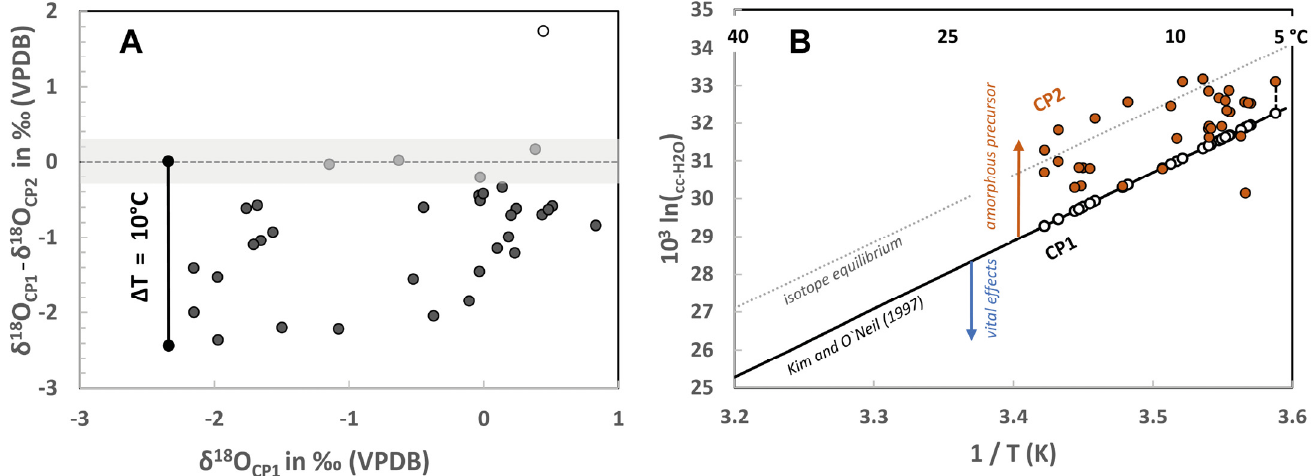
Figure 4. ( A ) Difference between the oxygen isotope composition of CP1 and CP2 calcite ( 18 O CP1- δ 18 O CP2 in ‰) from spot analyses within a 25-µm distance from each other. CP2 is isotopically heavier than CP1 calcite, except two cases showing identical CP2 and CP1 values within the analytical precision (shaded area) and one case with a contrary behavior. ( B ) Oxygen isotope fractionation between calcite (cc) and water (10 3 ln( α cc-H2O )) as a function of temperature (T in K). ○ and ● : data for CP1 and CP2 calcite, where α cc-H2O = ( δ 18 O CPi + 1000)/( δ 18 O H2O + 1000) (i = 1, 2; see values in Table S1) are estimated by considering Mesozoic seawater to be δ 18 O H2O (SMOW) ≈ − 1.0 ‰ (equal to − 30.95 ‰, VPDB) at ice-free condition [48]. Black, solid line is obtained from inorganic calcite precipitation experiments at low precipitation rates [38] and is used as a T CP1 calibration line for CP1 calcite, representing a baseline for biogenically induced calcite. CP2 calcites are plotted vs. T CP1 values, assuming identical formation temperatures for CP1 and CP2, to follow the shift of oxygen isotope fractionation from CP1 to CP2, suppressing T effects (exemplarily indicated by the dashed line at about 6 °C). Dotted line: oxygen isotope equilibrium conditions, as proposed by Daëron et al. [33], from calcitic speleothems. Blue arrow: trend of increasing impact of vital effects on calcite precipitation (including precipitation rate and DIC disequilibrium effect (e.g., [5])). Red arrow: trend of increasing impact of calcite formed via amorphous Ca-Mg carbonate precursors at high solid-to-liquid ratio, i.e., water is limited during the transformation [7].